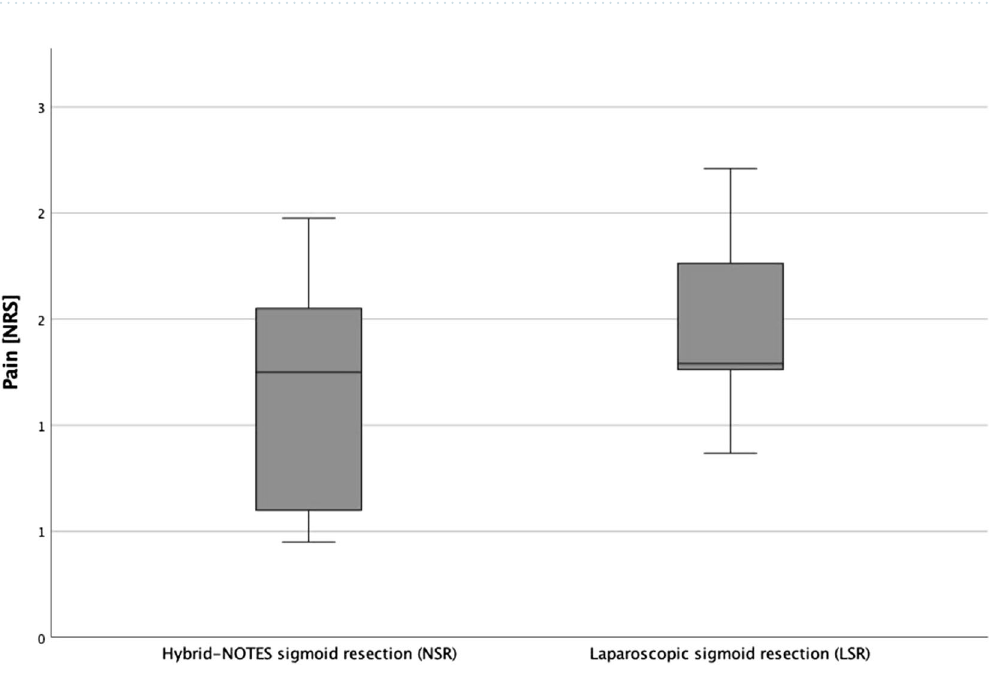
Figure 4. Average sum of pain